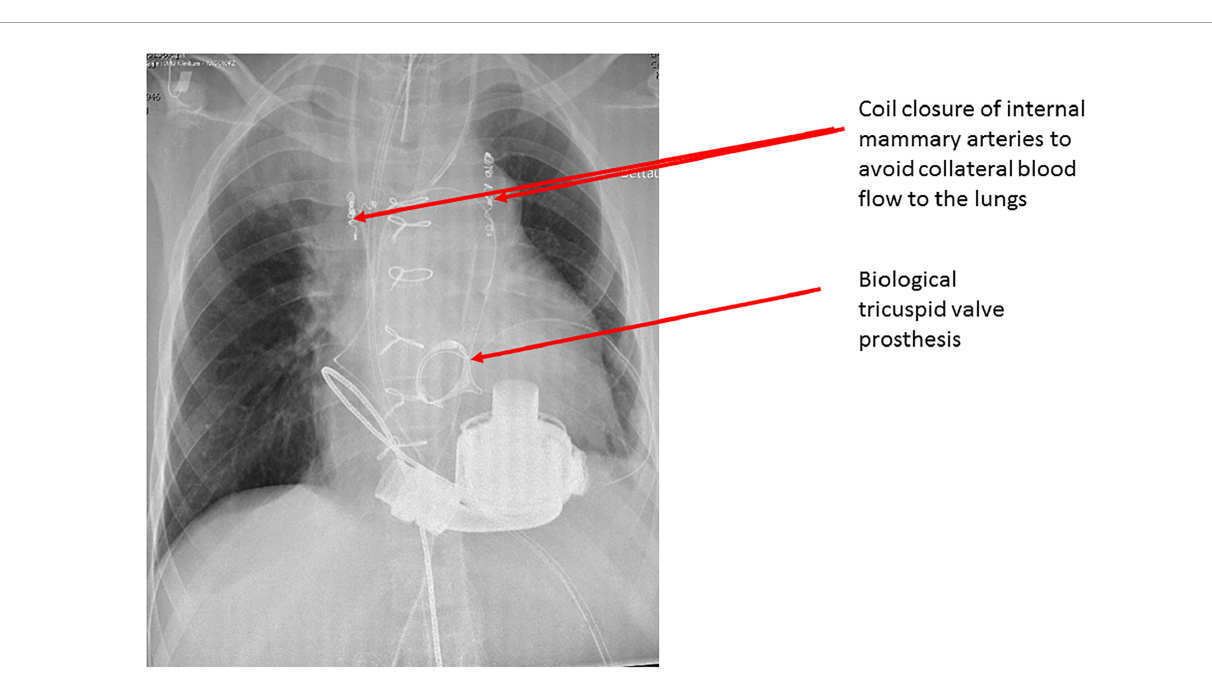
Frontiers in Cardiovascular